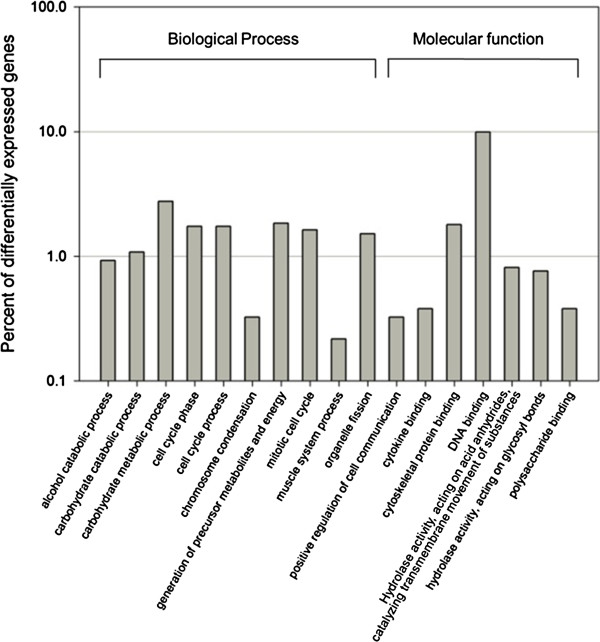
GO assignment of genes up- or down-regulated in balstema compared with the control non-regenerating limb stump. The results of GO biological function assignment annotation of differentially expressed genes are summarized in two main categories: biological process and molecular function.